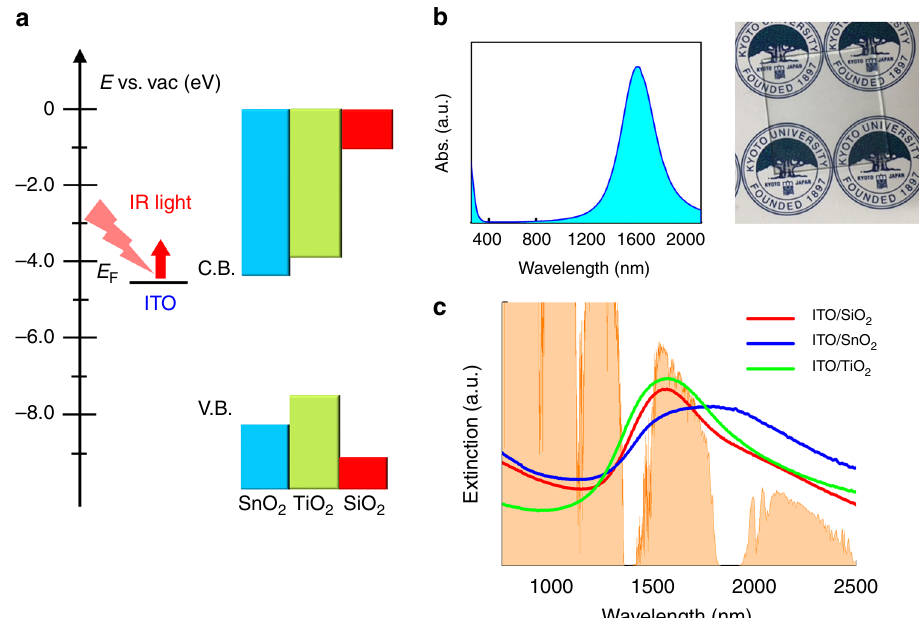
Fig. 1 Energy diagrams and optical properties. a Energy diagrams of the indium tin oxide (ITO) nanocrystals (NCs) and metal oxides. The E F values of ITO NCs and the conduction band edges of SnO 2 and TiO 2 were obtained from references 10 – 12 , respectively. C.B. conduction band; V.B. valence band. b Left- hand side image: absorption spectrum of ITO NCs in CHCl 3 solution. Right-hand side image: ITO-NC-coated glass substrate. c Extinction spectra of the ITO/SiO 2 , ITO/TiO 2 and ITO/SnO 2 after reductive annealing. The spectrum shown in orange is the solar spectrum (AM